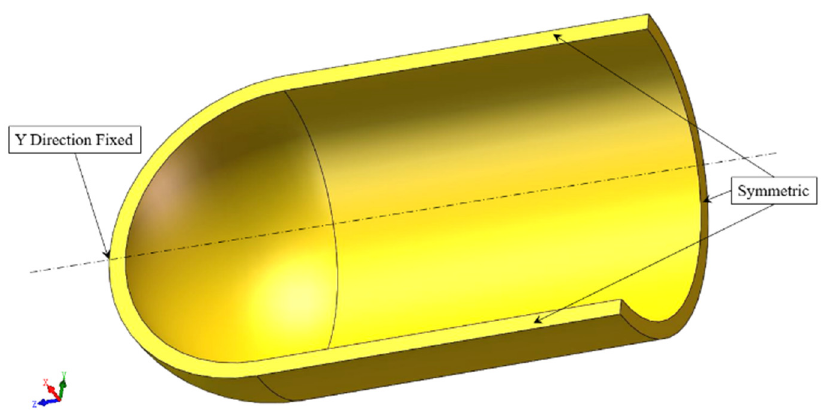
Figure 4. Boundary conditions of the finite element model.